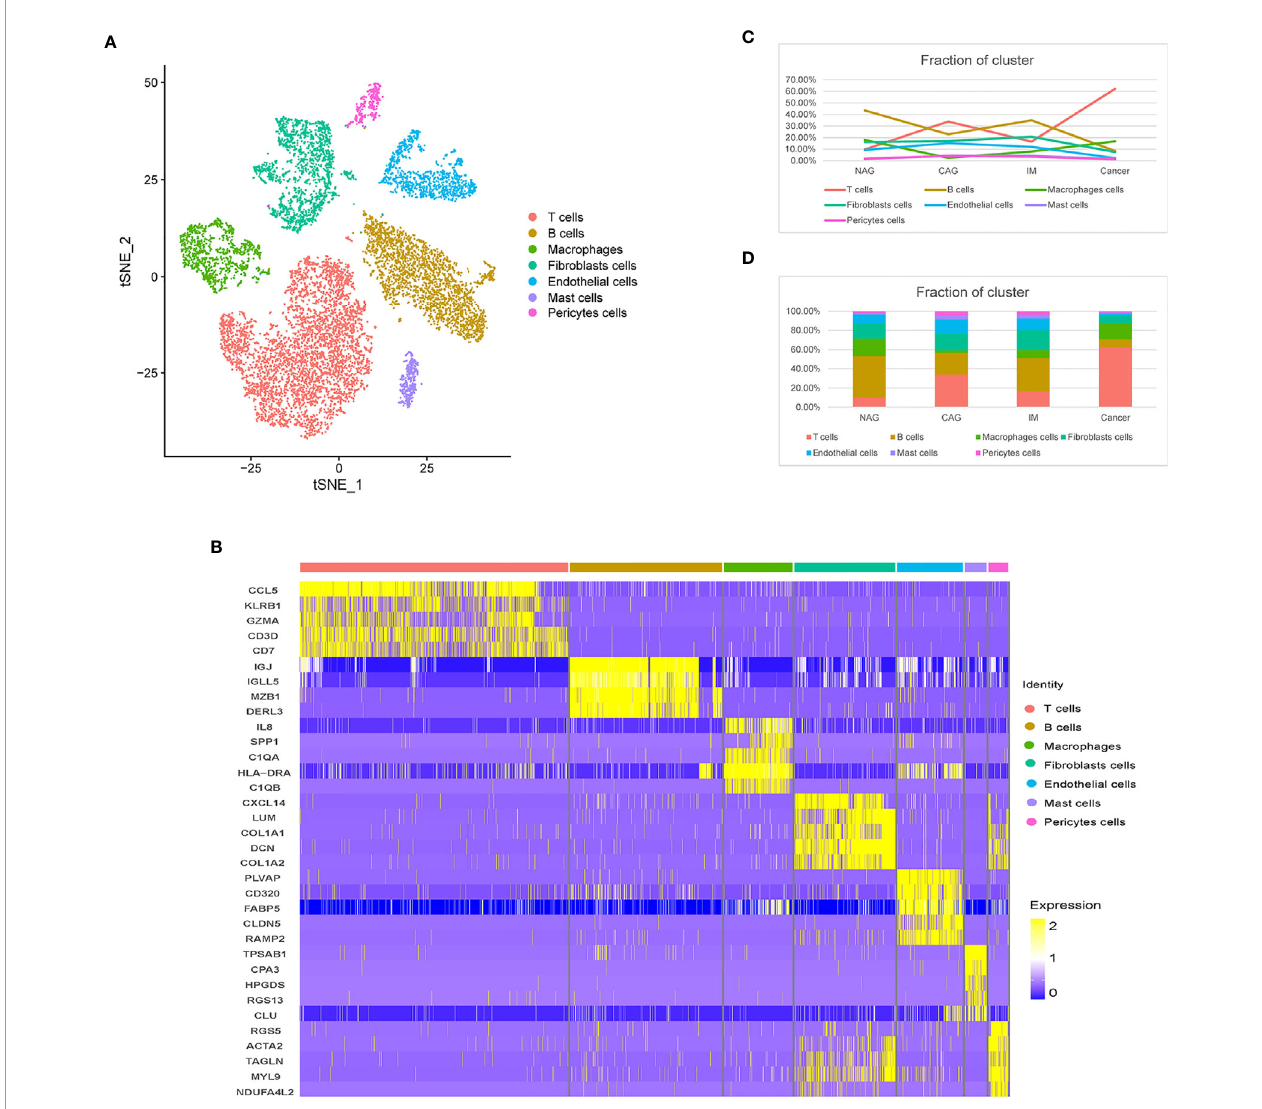
FIGURE 1 | Distinct TME cell populations and expression signatures. (A) tSNE plot of TME cells based on their differential expression. (B) Heatmap plots showing the expression of the top fi ve marker genes of seven major cell types identi fi ed in this pro fi le. (C) Line chart showing the trend of the proportion of TME cells across the four pathological stages (NAG-CAG-IM-GC). (D) Stacked histogram showing TME cell composition across the four pathological